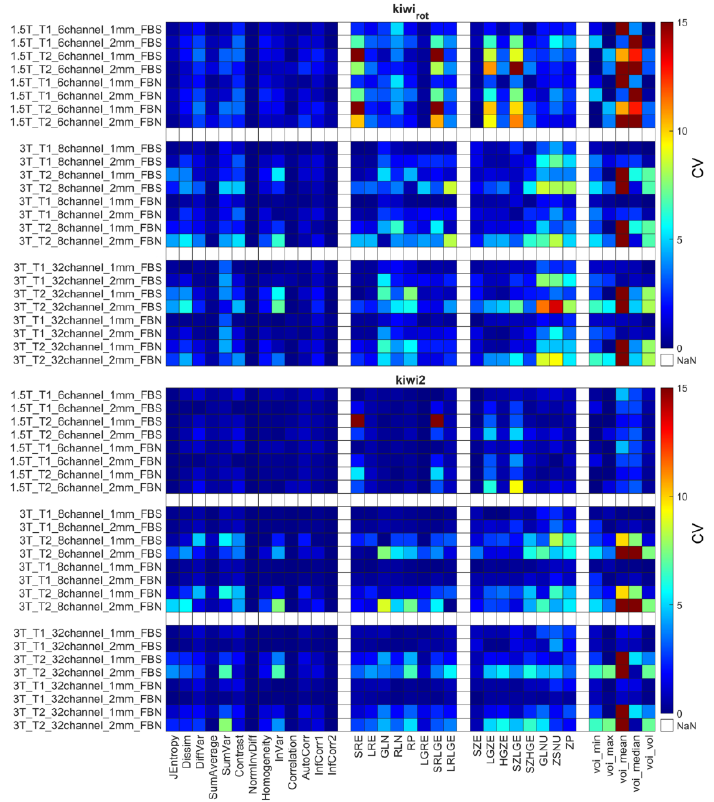
Figure 7. CV data for kiwi rot and kiwi2 objects. The CV is expressed in %. Table 6. Average CV values for each object and different settings or properties. The last row shows the CV average for the case when all objects’ data are included.